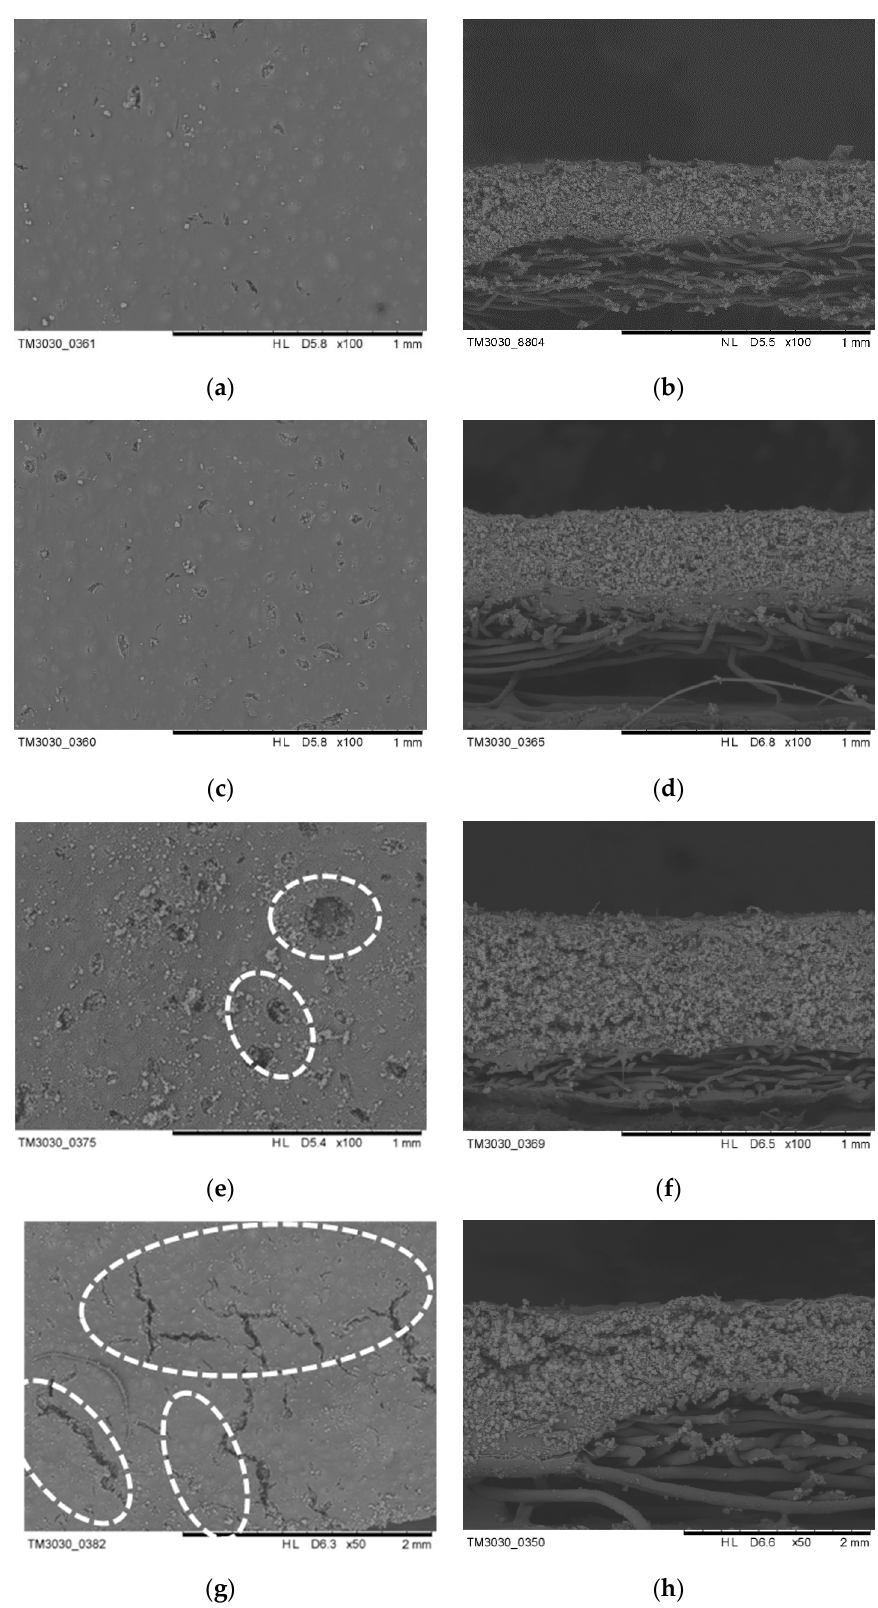
Figure 7. SEM images of the thermal insulation layer prepared at different coating thicknesses: ( a )( b ) 0.5 mm; ( c )( d ) 0.75 mm; ( e )( f ) 1 mm, the circles in (e) indicate the holes; ( g )( h ) 1.5 mm, the circles in (g) indicate the cracks.